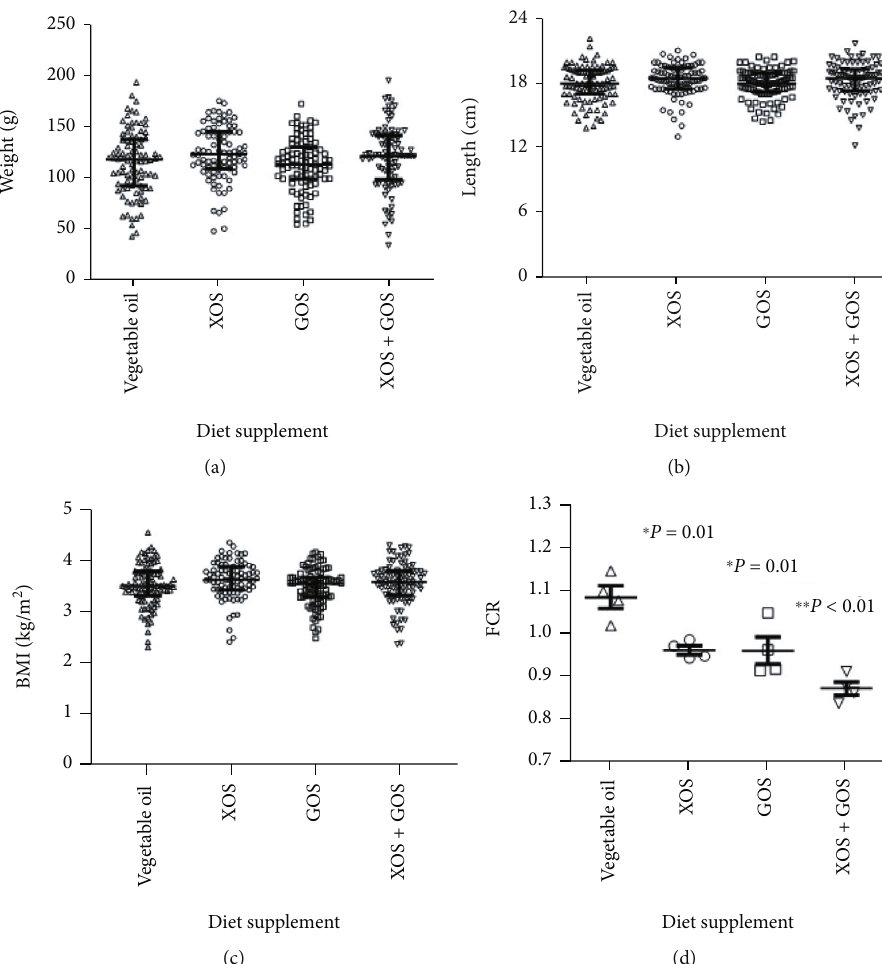
Figure 2: Growth performance of the three-month juvenile O. niloticus . Parameters, including wet weight (a), body length (b), and the BMI (c) of the fi sh, were used to assess the growth performance. FCR was calculated to estimate the nutrient transformation from fi sh diets to fi sh growth (d). ∗ 0 : 01 < p < 0 : 05 ; ∗∗ p < 0 : 01 ; n = 33 − 45 . n = 86 − 95 for (a) – (c) and 4 for